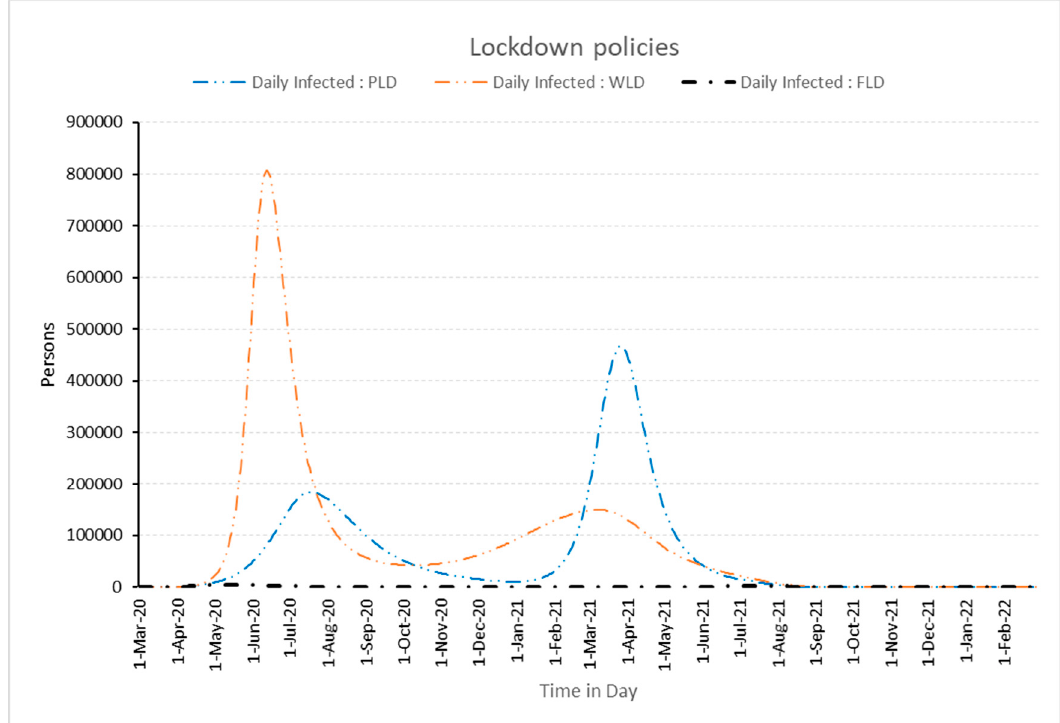
Figure 8. Impact of different lockdown policies on daily infected people.